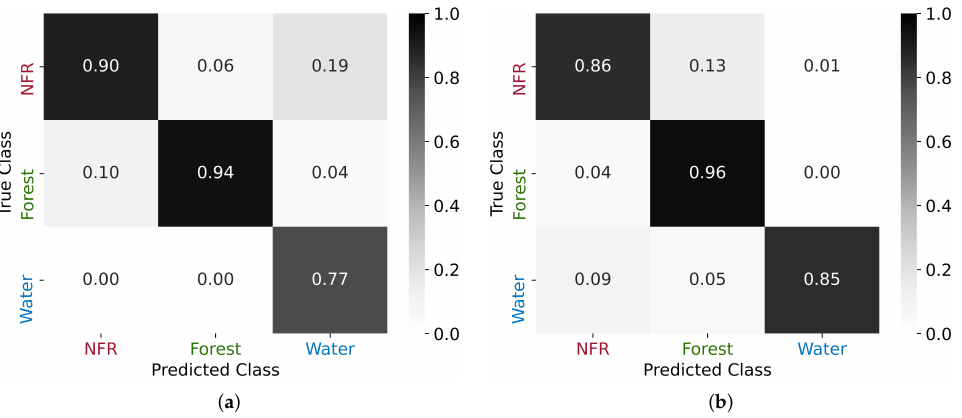
Figure 9. Confusion matrices for the CNN scheme proposed in case X : ( a ) normalized by the predicted class and ( b ) normalized by the true class.